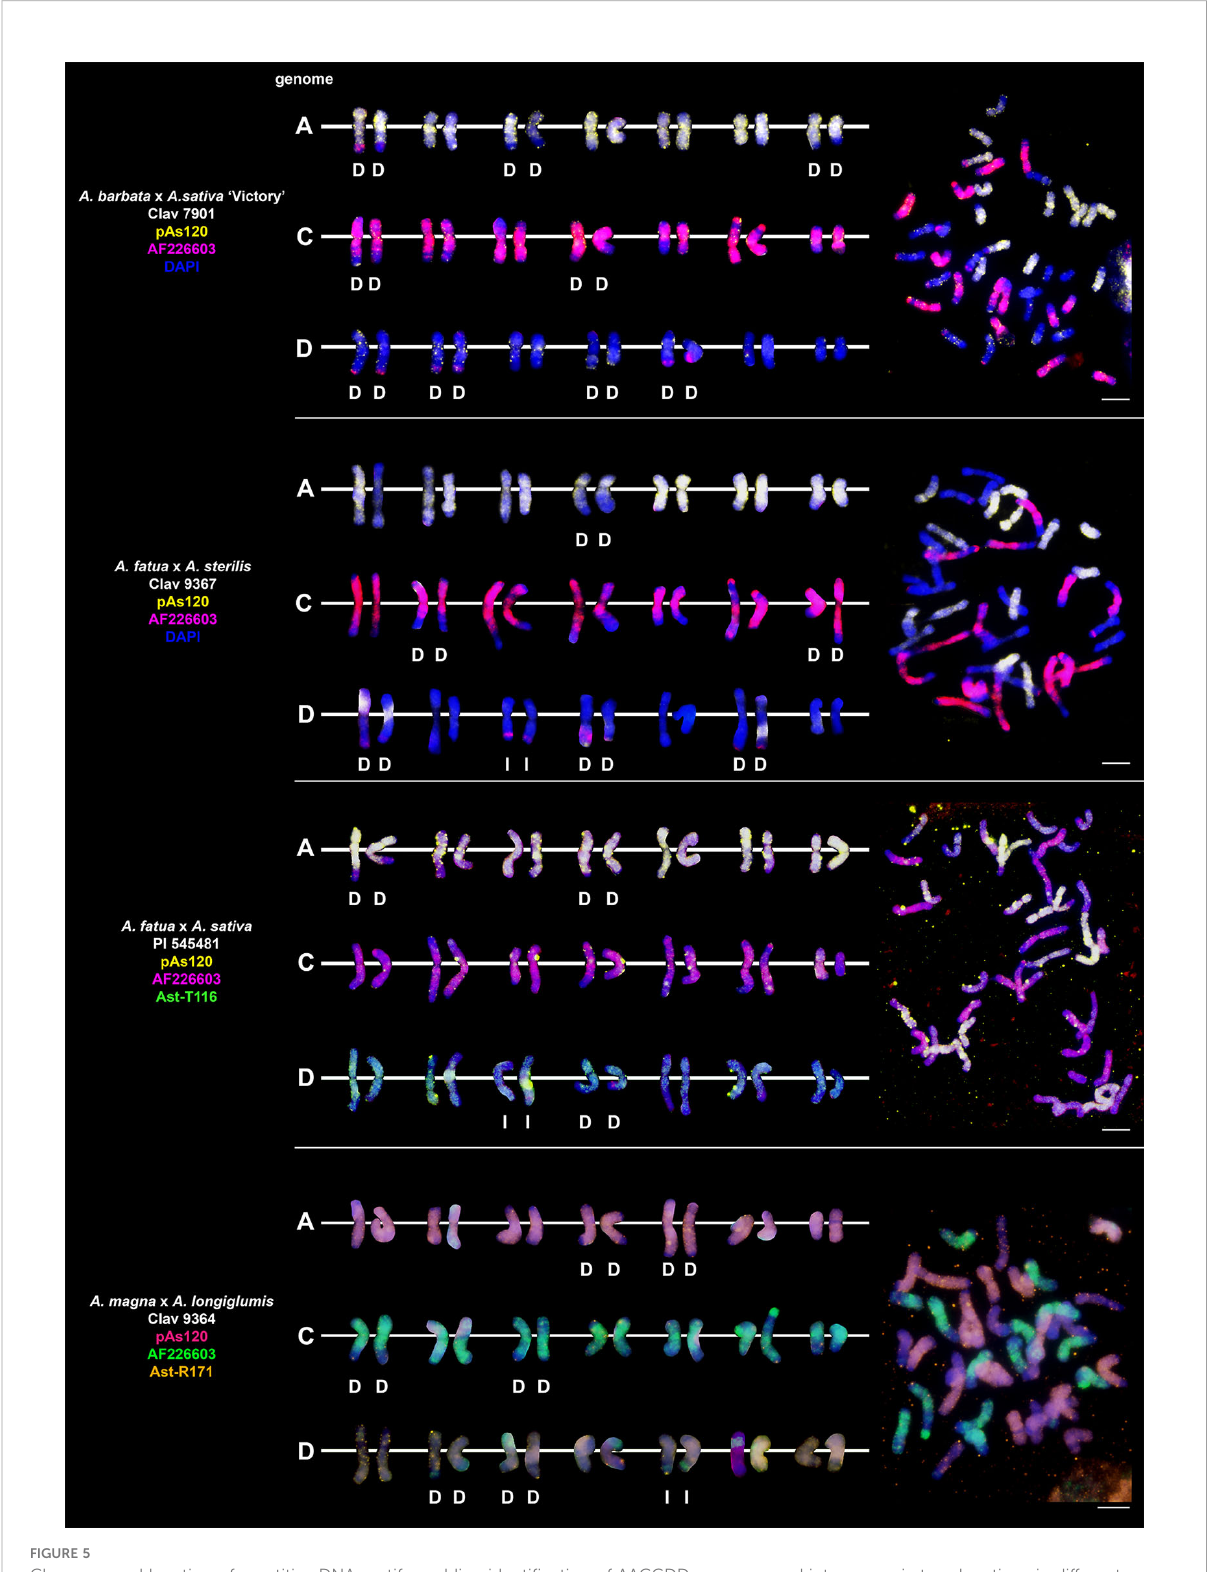
FIGURE 5 Chromosomal location of repetitive DNA motifs enabling identi fi cation of AACCDD genomes and intergenomic translocations in different hexaploid hybrids and amphiploids of oats. D- distal translocation, I- interstitial translocation. Scale bar = 10 m